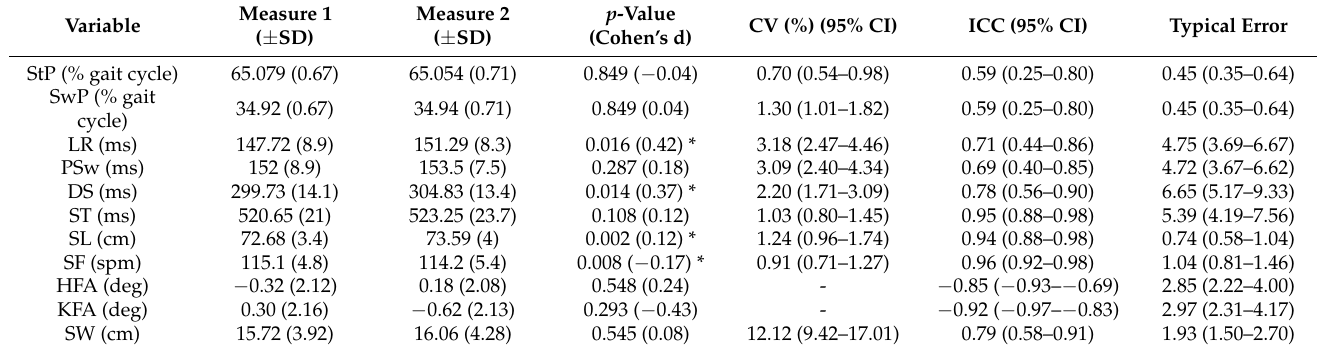
Table 2. Descriptive data (means, ± SD) and inter-session reliability of kinematic parameters obtained from Kinect + MotionMetrix software walking at 5 km · h − 1